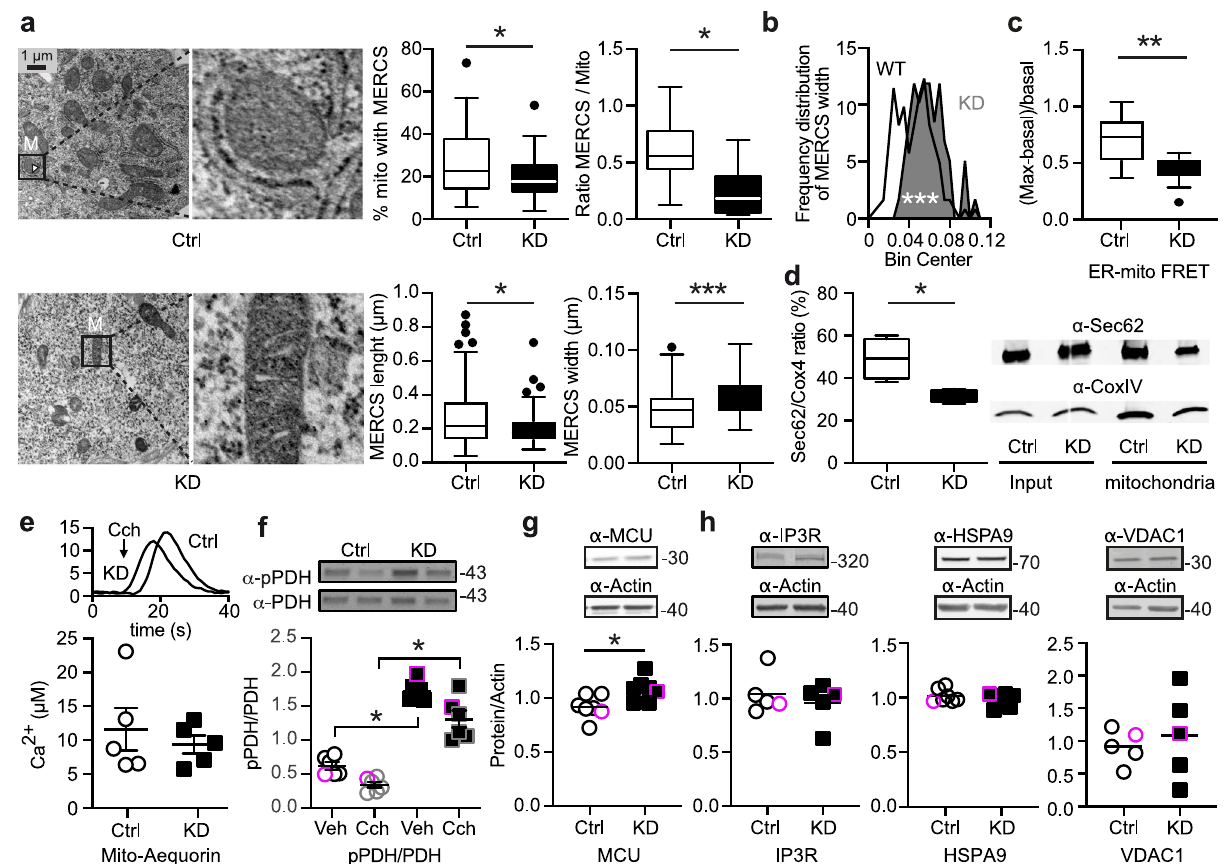
Fig. 5 GDAP1 knockdown reduces the number of contact sites between mitochondria and the endoplasmic reticulum. a Transmission electron microscopy of knockdown (KD) and control (Ctrl) cells. The indicated parameters were quanti fi ed using ImageJ by a blinded investigator. M, mitochondrion. b Histogram showing the distribution of MERCS ’ widths, and an increased distance in KD cells between the ER and mitochondria. c Proximity of ER and mitochondria was measured using a FRET-FEMP sensor comprising ER CFP-Sac1 and mitochondrial YFP-Akap1. Proximity leads to high intensity of YFP-FRET-emission (410-430/520-560 ex/em). 100 nM rapamycine was added to achieve the closest possible distance, and the measurement of FRET ratio was calculated as (FRET max -FRET basa l)/FRET basal . d Quanti fi cation of ER membrane (Sec62) and mitochondrial (Cox4) proteins in mitochondrial fractions. e Representative curve for the aequorin Ca 2 + measurement and quanti fi cation of mitochondrial Ca 2 + levels after addition of 200 µ M carbachol (CCH), which releases Ca 2 + from the ER by activation of a G-protein-coupled receptor. f) Immunoblot of Ctrl and KD cells lysed 10 min after 200 µ M CCH addition to quantify the PDH phosphorylation (pPDH/(PDH total ) after Ca 2 + release into the MERCS and mitochondria. g , h Immunoblot of total cell lysates of Ctrl and KD cells showing increased expression levels of MCU but not pan-IP3R, HSPA9 or VDAC1, actin served as loading control, size is indicated. Data in ( a ) were obtained from 11 (Ctrl) and 9 (KD) cells, in ( b ) from 4 independent experiments in triplicate or quintuplicate with a range of 162 – 818 cells per experiment, and in ( d ) from 4 independent experiments. Data in ( e ) from 5 independent experiments performed in triplicates. Data points corresponding to the example blots are highlighted. Statistical variation is shown as Tukey boxplots or scatter plots with the indication of mean ± SEM and signi fi cance was calculated using the non-parametric Mann – Whitney test, * p < 0.05, ** p < 0.001, *** p <